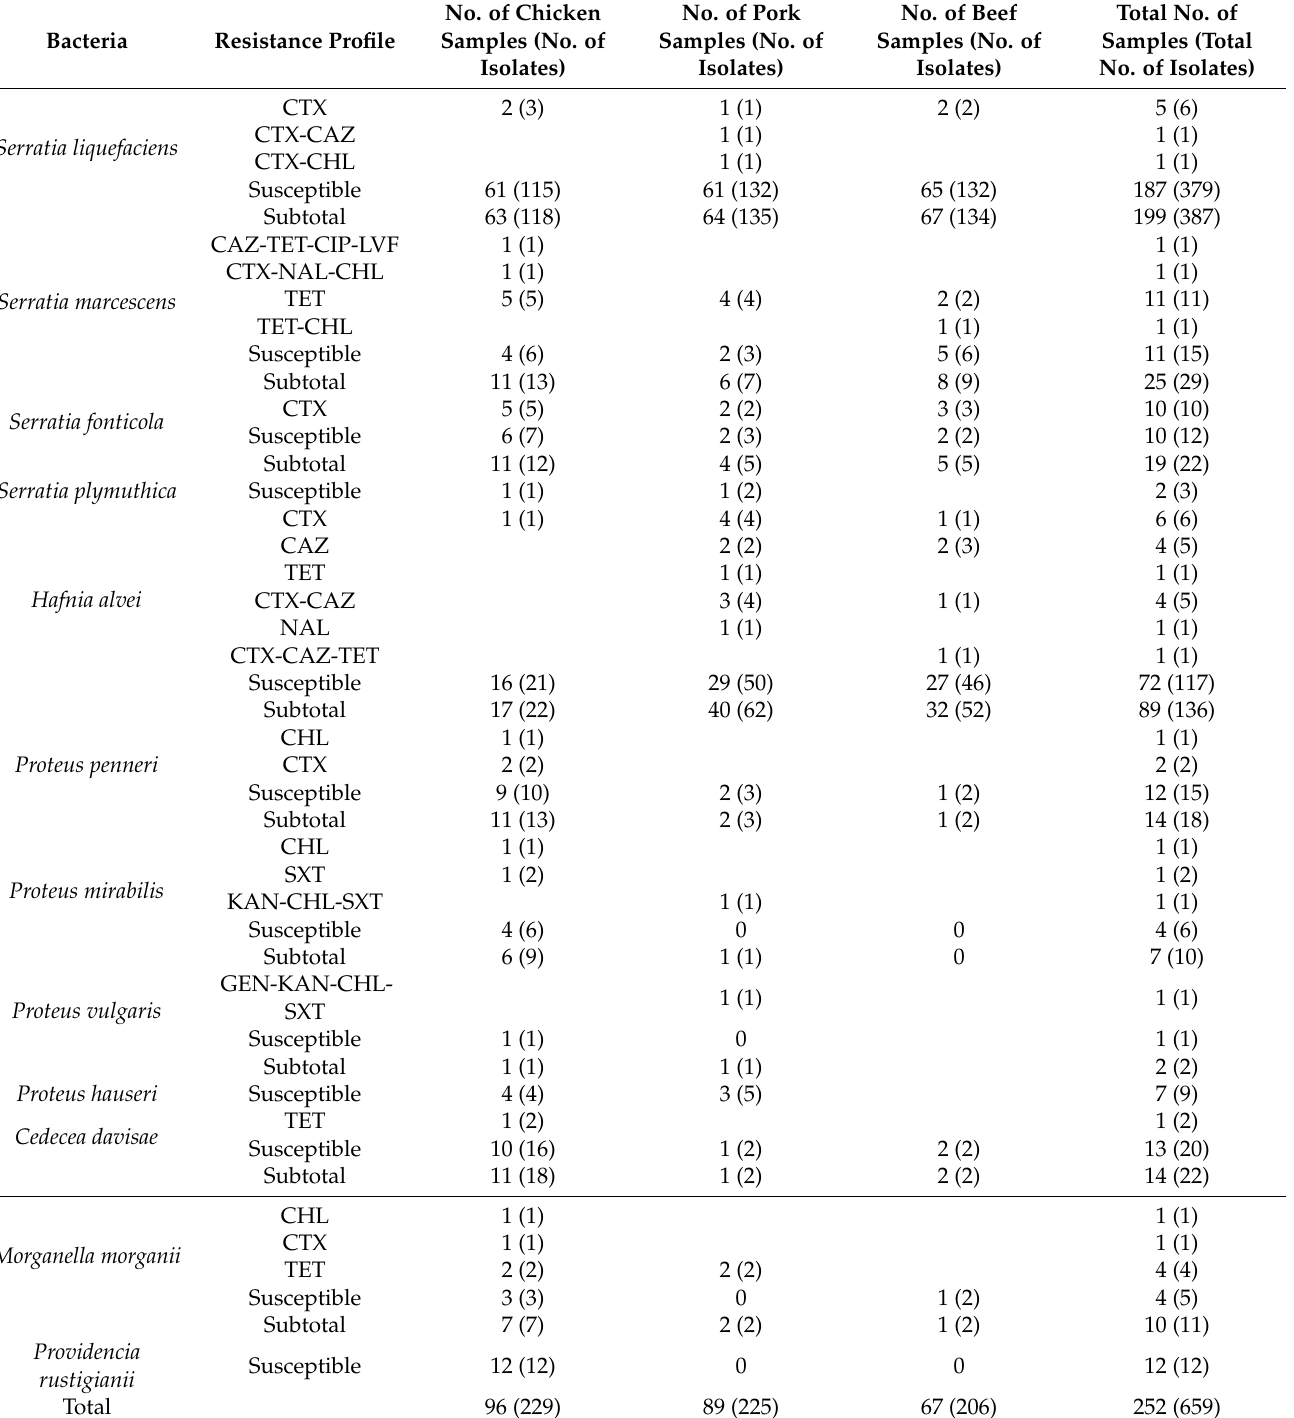
Table 2. Antibiogram of the intrinsic colistin-resistant Enterobacterales found in the retail chicken, pork, and beef samples